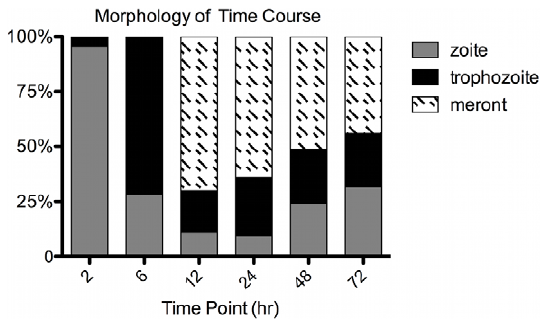
Figure 1. Quantification of Parasite Stage Progression. HCT-8 coverslips were infected and stained with pan-specific antibody to quantify C. parvum infection. . 300 parasites were counted on 15–30 frames for each of four replicates for each time point. The average for each of the 3 stages of parasite determined was converted into a percentage of the total parasite detected per time point. zoite = sporozoite/merozoite, trophozoite = all trophozoites (size of stained parasite was . zoite but , merozoite), meront = all parasites staining